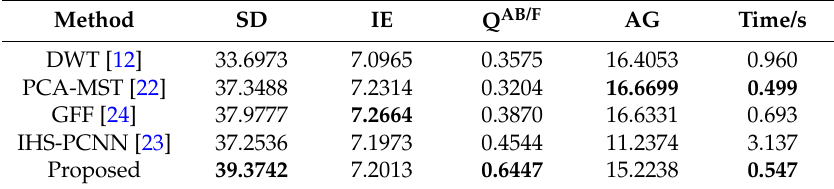
Table 4. Evaluation of Field (noise-adding) IR-visible image fusion